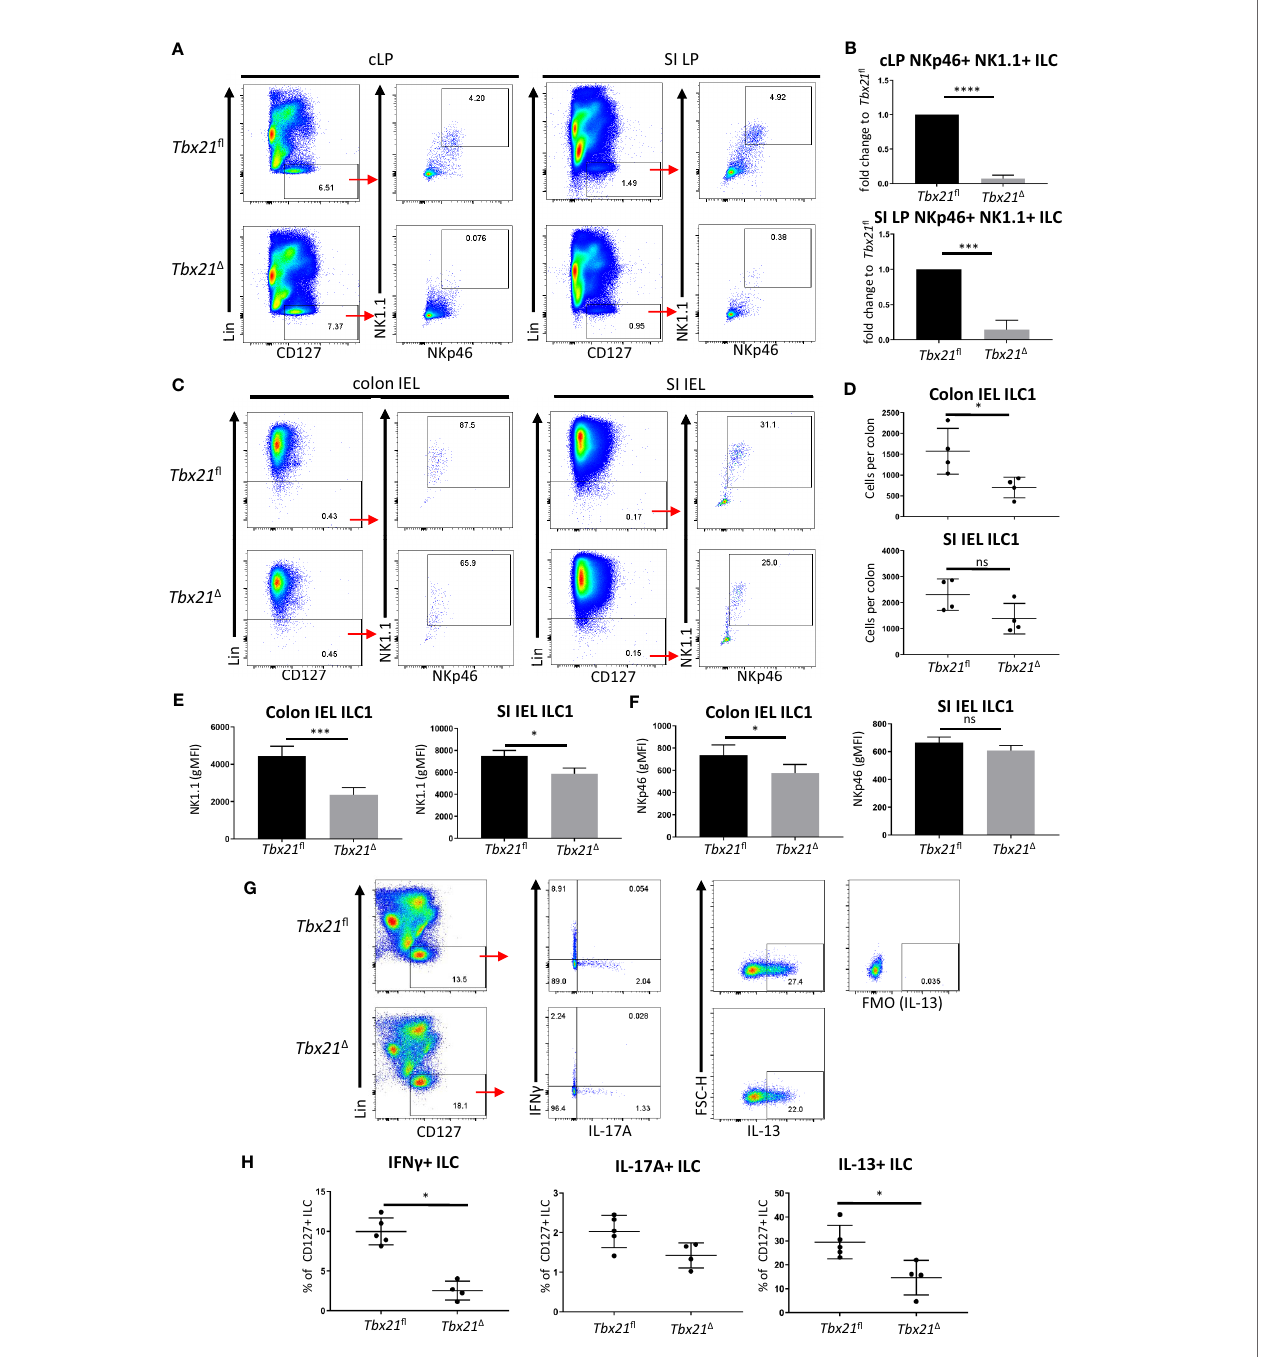
FIGURE 1 | Induced T-bet depletion in vivo causes complete loss of intestinal ILC1. ILC were isolated from tamoxifen-treated Tbx21 fl and Tbx21 D mice for fl ow cytometry analysis 21 days after the fi rst injection of tamoxifen. (A, B) cLP and SI LP ILC1 were analysed as live CD45 + Lin - CD127 + NKp46 + NK1.1 + leukocytes and (B) the percentage fold change of NKp46 + NK1.1 + ILC of total CD127 + ILC in the Tbx21 D mice in comparison to the Tbx21 fl controls was determined (n=3). Intestinal IEL ILC were isolated from tamoxifen-treated Tbx21 fl and Tbx21 D mice for fl ow cytometry analysis. IEL ILC1 were analysed as live CD45 + Lin - NKp46 + NK1.1